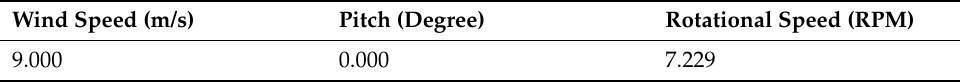
Table 1. The operational parameters.